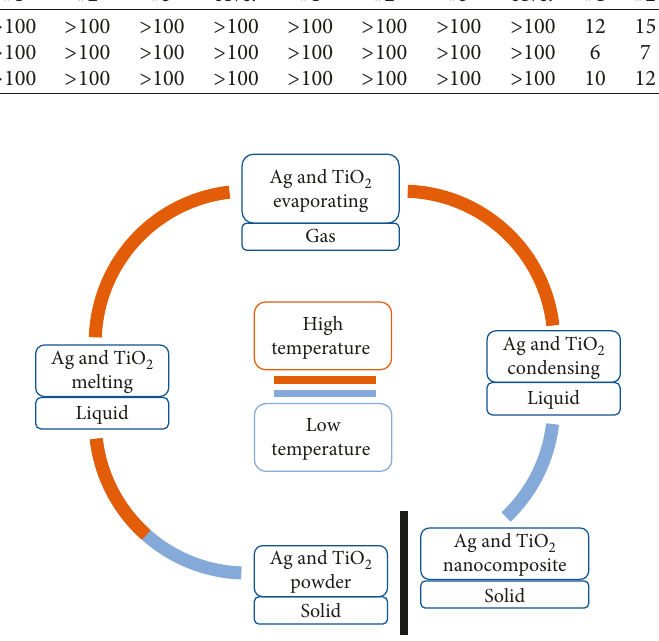
Figure 12: Material